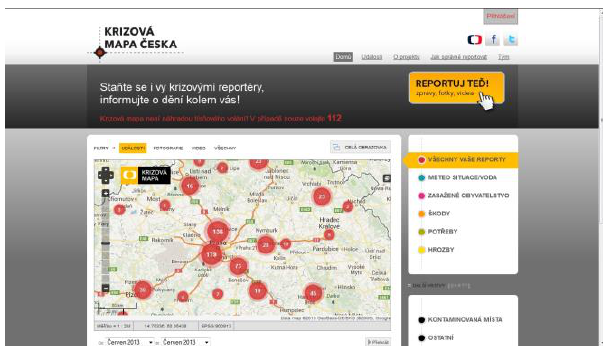
Figure 3. Crisis Map of Czechia – active status, flood 2013